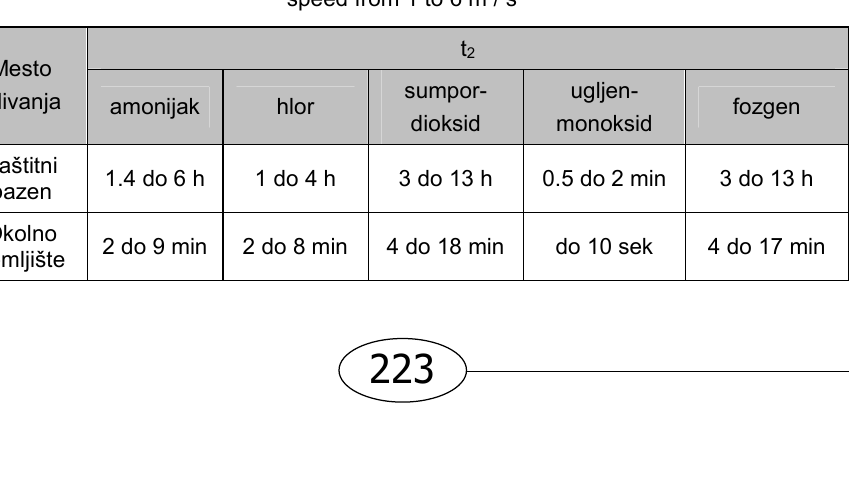
Table 4 - Approximate duration (t2) of chemical contamination in the area of the accident, depending on the type and weight of hazardous substances in the tank, at a spill into a protective pool or on wet soil at a temperature of 20 degrees Celsius and at a